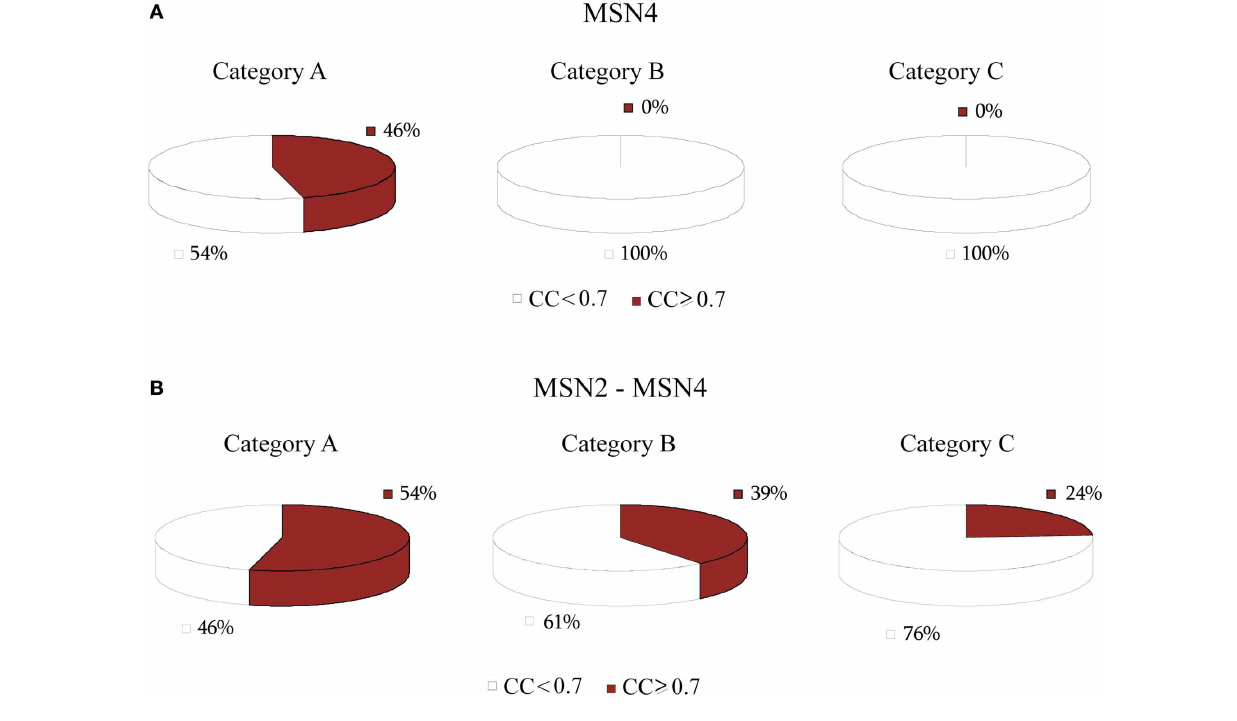
were found in categories B and C. (B) Results that correspond to genes in modules regulated by MSN4 and MSN2. In this case the ANN performance is improved in all three categories, with Category A having the majority of the successful ANNs, in agreement with experimental evidence.